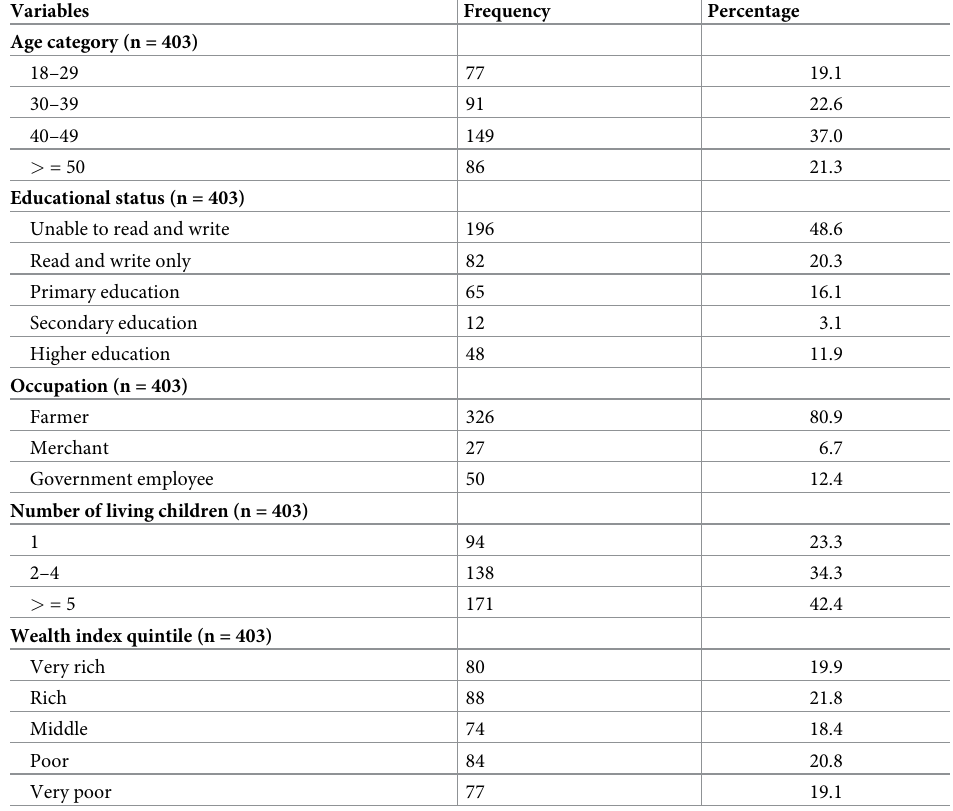
Table 1. Sociodemographic characteristics of study participants in North Achefer district, Northwest Ethiopia,